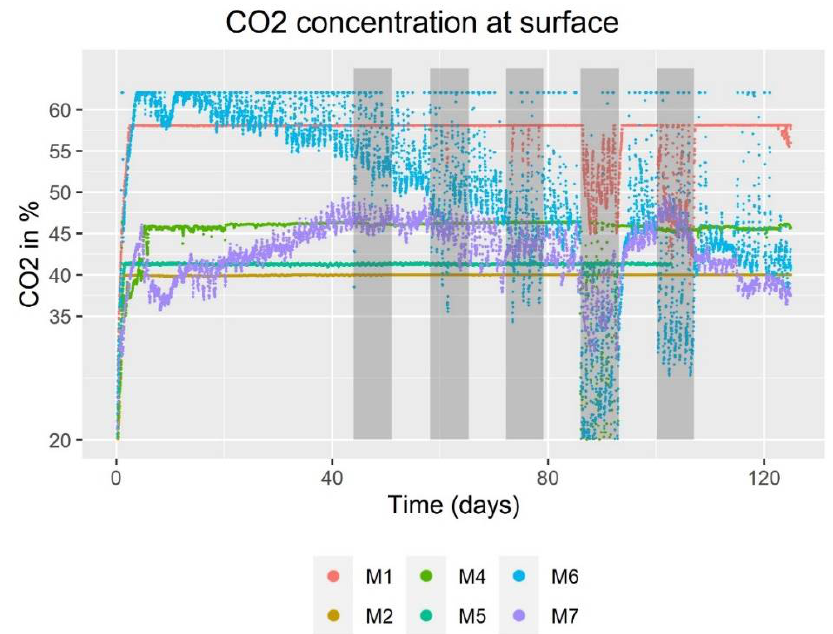
Figure 11. CO 2 concentration during the full-scale test within the trial field. As CO 2 sensors showed different calibrations, maximum amounts of CO 2 between each sensor differed. Within the grey highlighted areas, air breaches are conducted. Breaches 1–3 and 5 are at spot A, breach 4 is at spot B (Figure 2). As Module 8 broke within the first days, it is not